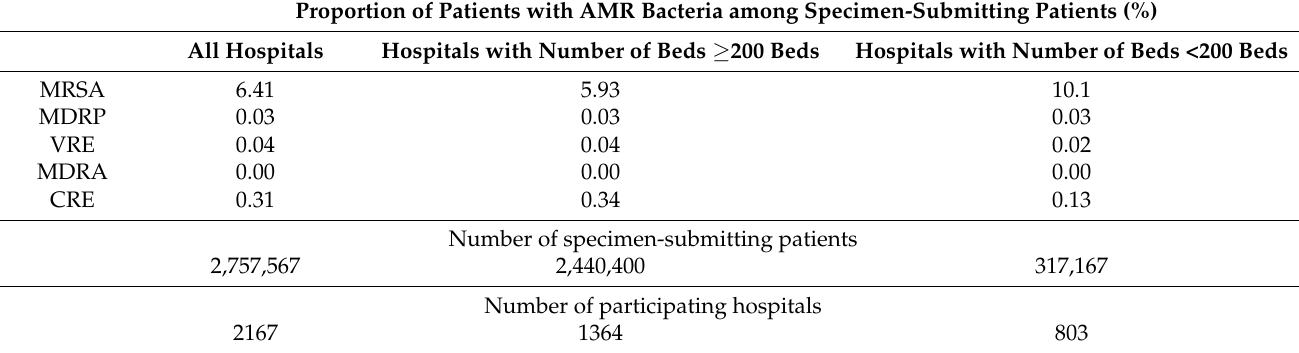
Table 2. Comparison of AMR bacteria prevalence based on hospital size, 2020 JANIS-CL annual report. Proportion of Patients with AMR Bacteria among Specimen-Submitting Patients (%) Hospitals with Number of Beds All Hospitals ≥ 200 Beds